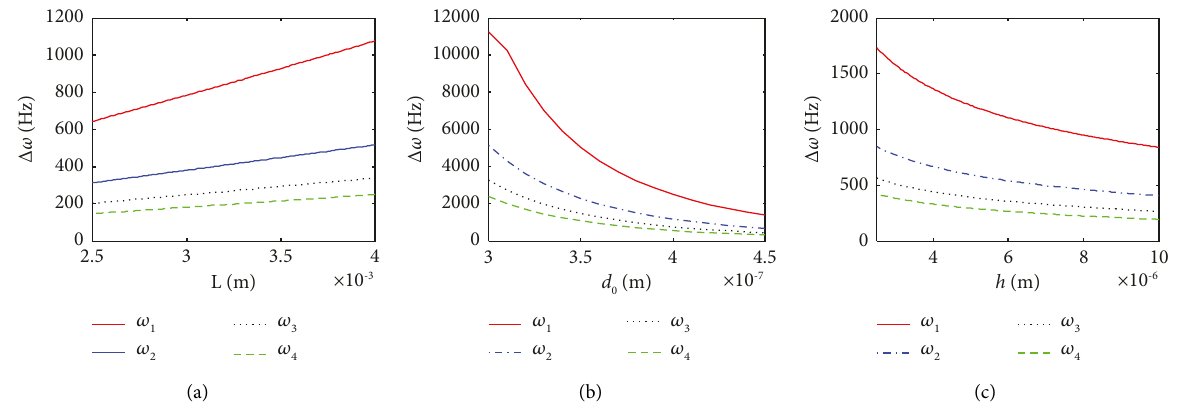
Figure 8: Changes of the resonant frequency differences with system parameters (odd modes) (a) length changes (b) clearance changes (c) thickness changes.